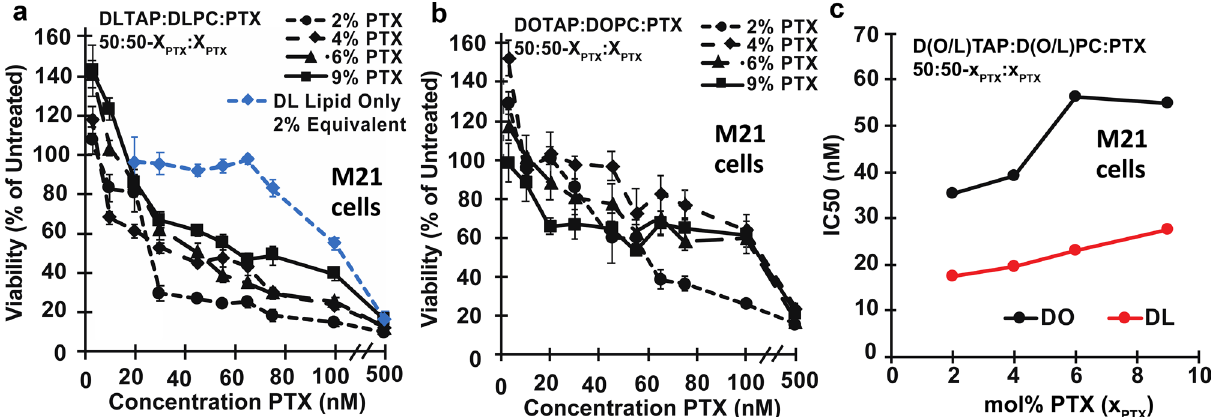
Figure 8. Cytotoxicity of PTX-loaded CLs against M21 cells. ( a ) Viability of M21 cells (relative to untreated cells) as a function of PTX concentration for cells treated with CLs of a molar composition of 50/50–x PTX /x PTX , DLinTAP/DLinPC/PTX, with x PTX = 2, 4, 6, or 9 (black lines). Cell viability decreased with PTX concentration to a similar level as observed for PC3 cells, albeit more gradually. As a control, DLinTAP/DLinPC CLs without PTX were added to M21 cells in amounts matching the lipid content of CLs with x PTX = 2 (which have the highest lipid content) at the PTX concentrations tested (blue line). The control showed no cytotoxicity (≥ 90% viability) up to the lipid equivalent of 75 nM PTX delivered with x PTX = 2. This suggests that PTX, not lipid, drove cytotoxicity at the IC50 of every formulation because CL cytotoxicity manifests only at concentrations at least four times the IC50 (see part c ). ( b ) Viability of M21 cells (relative to untreated cells) as a function of PTX concentration for cells treated with control CLs of a molar composition of 50/50–x PTX /x PTX , DOTAP/ DOPC/PTX, with x PTX = 2, 4, 6, or 9 (black lines). The decrease in cell viability with PTX concentration is less steep than in part A, suggesting a lower efficacy. At the employed concentrations, CLs without PTX do not elicit cytotoxicity 48 . ( c ) Plot of IC50 values for PTX cytotoxicity against M21 cells for the CL formulations based on lipids with linoleoyl (“DLin”, red line) and oleoyl (“DO”, black line) tails. Each IC50 was determined by fitting the corresponding cell viability curve (from parts a and b ) as described in the Methods section. Importantly, the (Fig. 4). In contrast to PC3 cells, the IC50 increases (efficacy decreases) with increasing PTX content for both DO and DLin formulations. This effect is less pronounced for the DLin formulations, and the IC50 of the